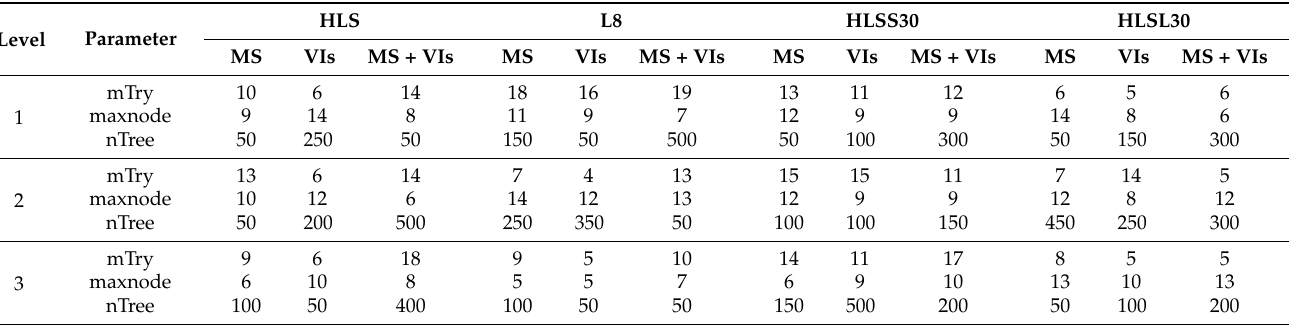
Table 4. Results of the parametrization considering the number of variables at each split (mTry), the number of trees in the forest (nTree), and the maximum number of terminal nodes (maxnode) for each model, after 10-fold